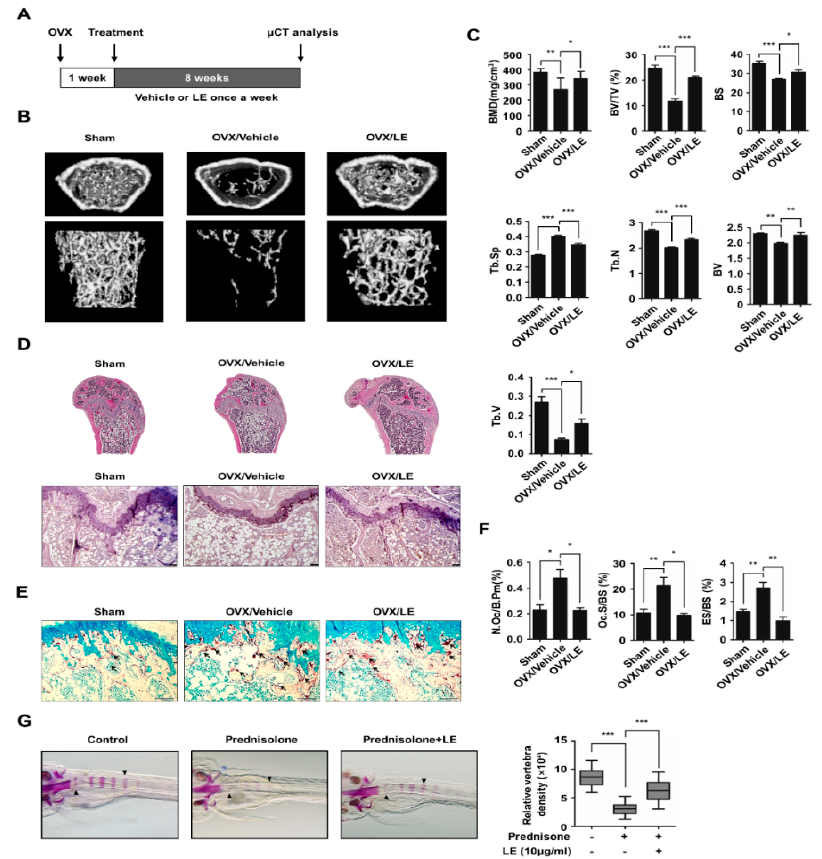
Figure 5. Leaf extract of Abeliophyllum distichum ameliorates bone loss in osteoporotic models. ( A ) Schematic representation of the experimental design of the ovariectomized mouse study. ( B ) Representative μ CT images of femurs of 18-week-old sham, vehicle-treated OVX, LE-treated OVX are shown. ( C ) Bone parameters including bone mineral density (BMD) and bone volume per total volume (BV/TV) were analyzed. ( D , E ) Histomorphometric analysis of bone. Tibial sections were stained with hematoxylin and eosin staining ( D ) and TRAP staining ( E ). Arrows indicate TRAP- positive osteoclast cells. ( F ) Parameters for osteoclastic bone resorption during bone morphometric analysis. Osteoclast surface per bone surface (Oc.S./B.S.), number of TRAP-positive osteoclasts per bone perimeter (N.Oc./B.Pm.), eroded surface per bone surface (ES/BS) are shown. ( G ) The larvae at 10 dpf. (days post-fertilization) were treated with 25 μ M prednisolone in the presence or absence of LE (10 μ g/mL) for 3 days. Whole-mount Alizarin red staining was performed to analyzed the mineralized bone. Relative vertebral bone density was assessed by measuring the areas of the first five stained vertebrae (V1—V5, indicated by arrowhead). 4. Discussion Osteoporosis is characterized by decreased bone mass and changes in the microarchitecture of bone, which increases bone fragility. It becomes a major health problem since the prevalence of this disease is increasing due to an aging population. Variable conventional treatments such as bisphosphonates, hormone therapy, calcitonin treatment, and selective estrogen receptor modulators are available for osteoporosis. However, since these treatments have been shown to cause severe adverse effects, new treatments with fewer adverse effects are needed for osteoporosis [32]. Recently, a series of natural products and herbal medicines have been reported for their anti-osteoporotic activities [33–35]. A. distichum has been shown to have several pharmaceutical properties including anti-cancer activity, anti-diabetic activity, and anti-hypertensive activity [15–17]. In the present study, we demonstrated that the LE of A. distichum has anti-osteoporotic activity by suppressing osteoclast differentiation. Furthermore, the transcriptome analysis showed that LE decreased the expression of